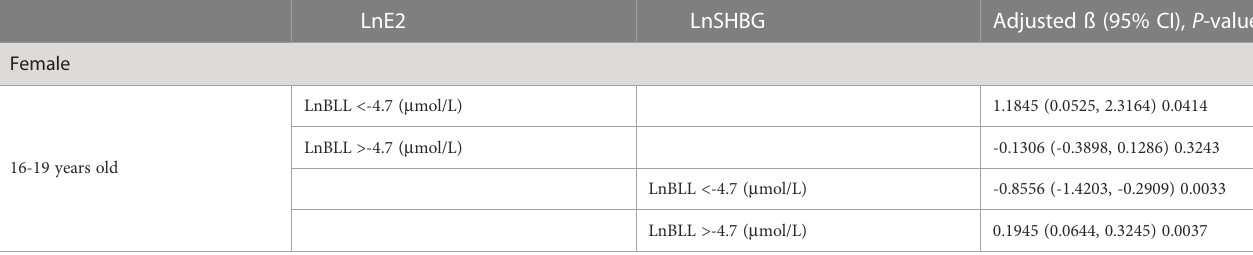
For two-piecewise linear regression model of LnBLL on LnSHBG, age, ratio offamily income to poverty; total energy, Ln(iron) and Ln(zinc) intake on the fi rst day; fi sh eaten during the past 30 days, moderate recreational activities, body mass index, hematocrit, serum continine, Ln(serum albumin), Ln(serum copper), Ln(serum zinc) were